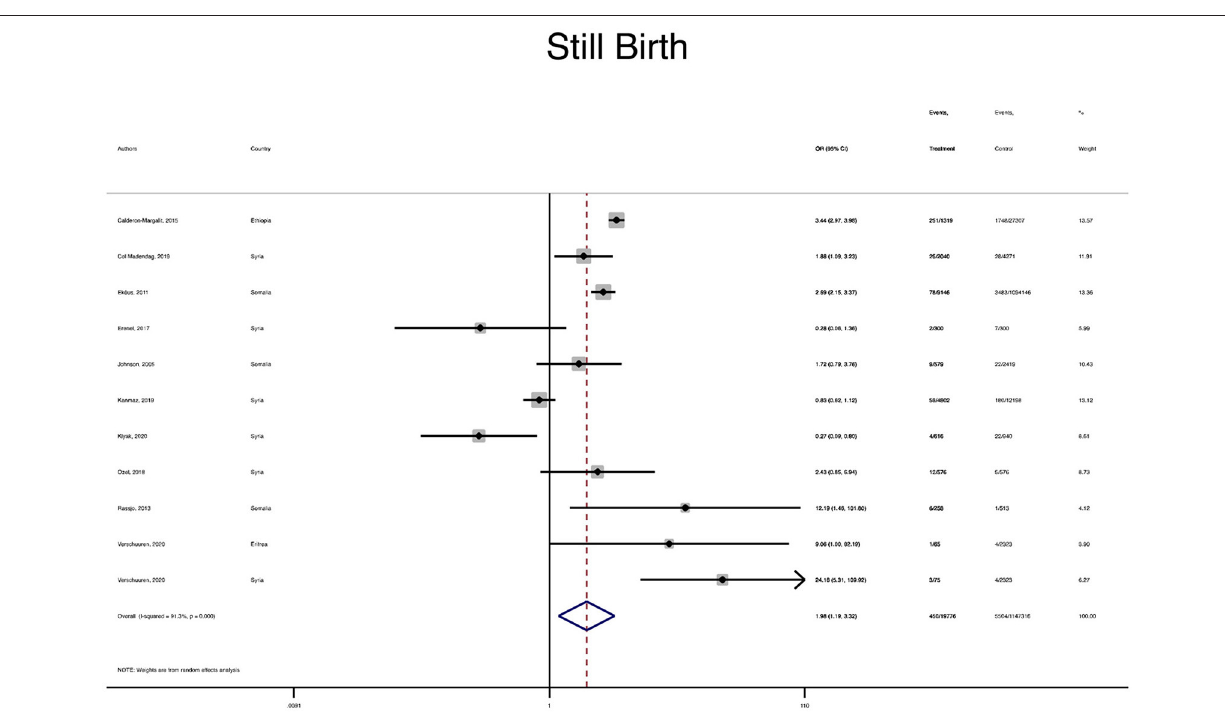
Frontiers in Public Health |